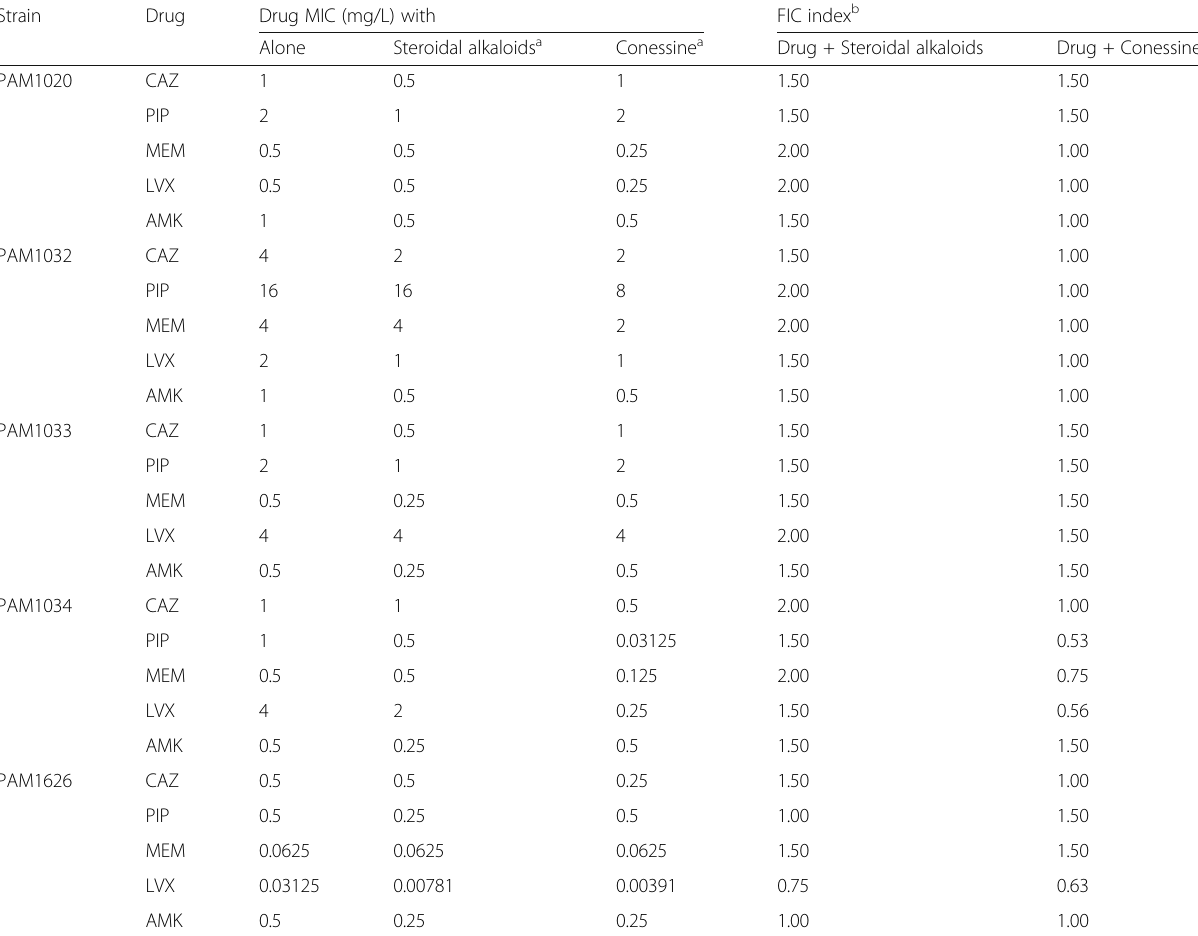
Table 1 MICs of five antibiotics alone and in the presence of Holarrhena antidysenterica steroidal alkaloids or conessine against P. aeruginosa PAM1020, 1032, 1033, 1034 and